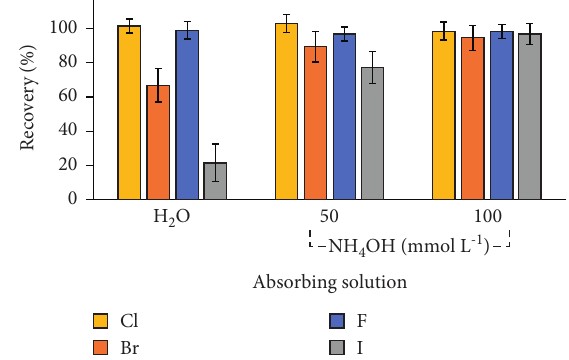
Figure 2: Recoveries obtained by IC for chlorine after the addition of 50% of the concentration obtained in the samples and for bromine, fluorine, and iodine after the addition of 1.5 times the concentration of the LOQs for each element ( n � 3).